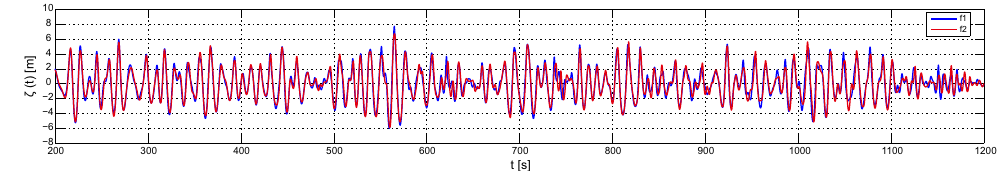
Figure 1. Comparison of two signals as an example of the correlation of SSP ≈